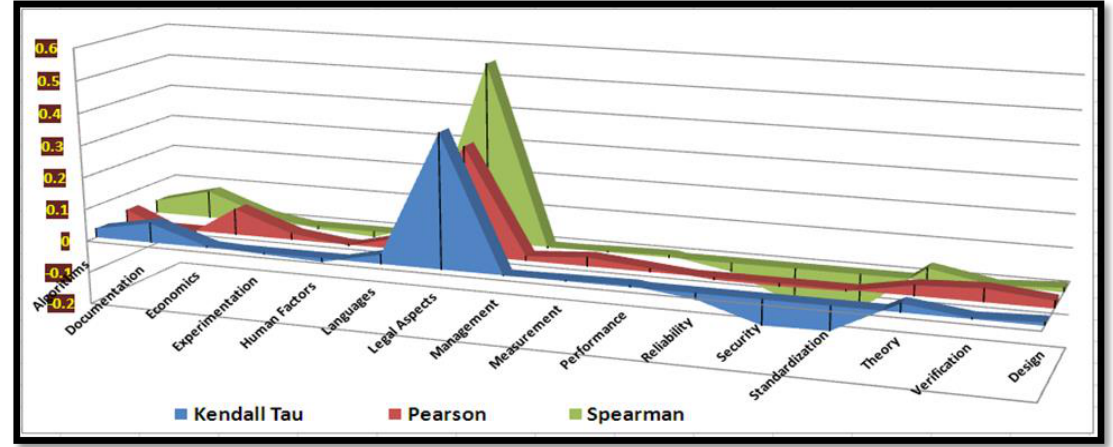
Figure 4. Correlation between non parametric values (web and non-web